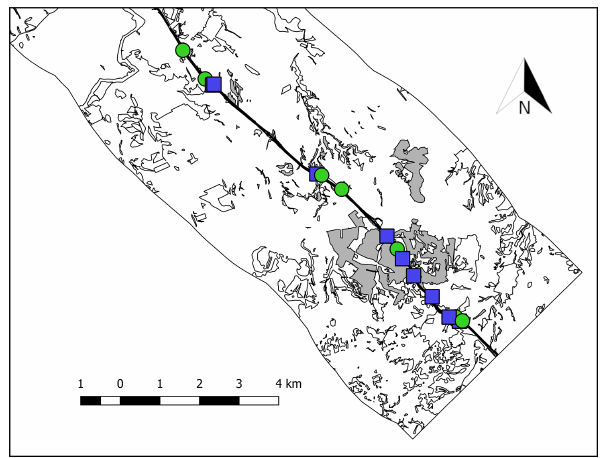
Figure 1. Map of the study area showing the road (in black), roadcuts (squares), embankments (circles) and natural remnants (in